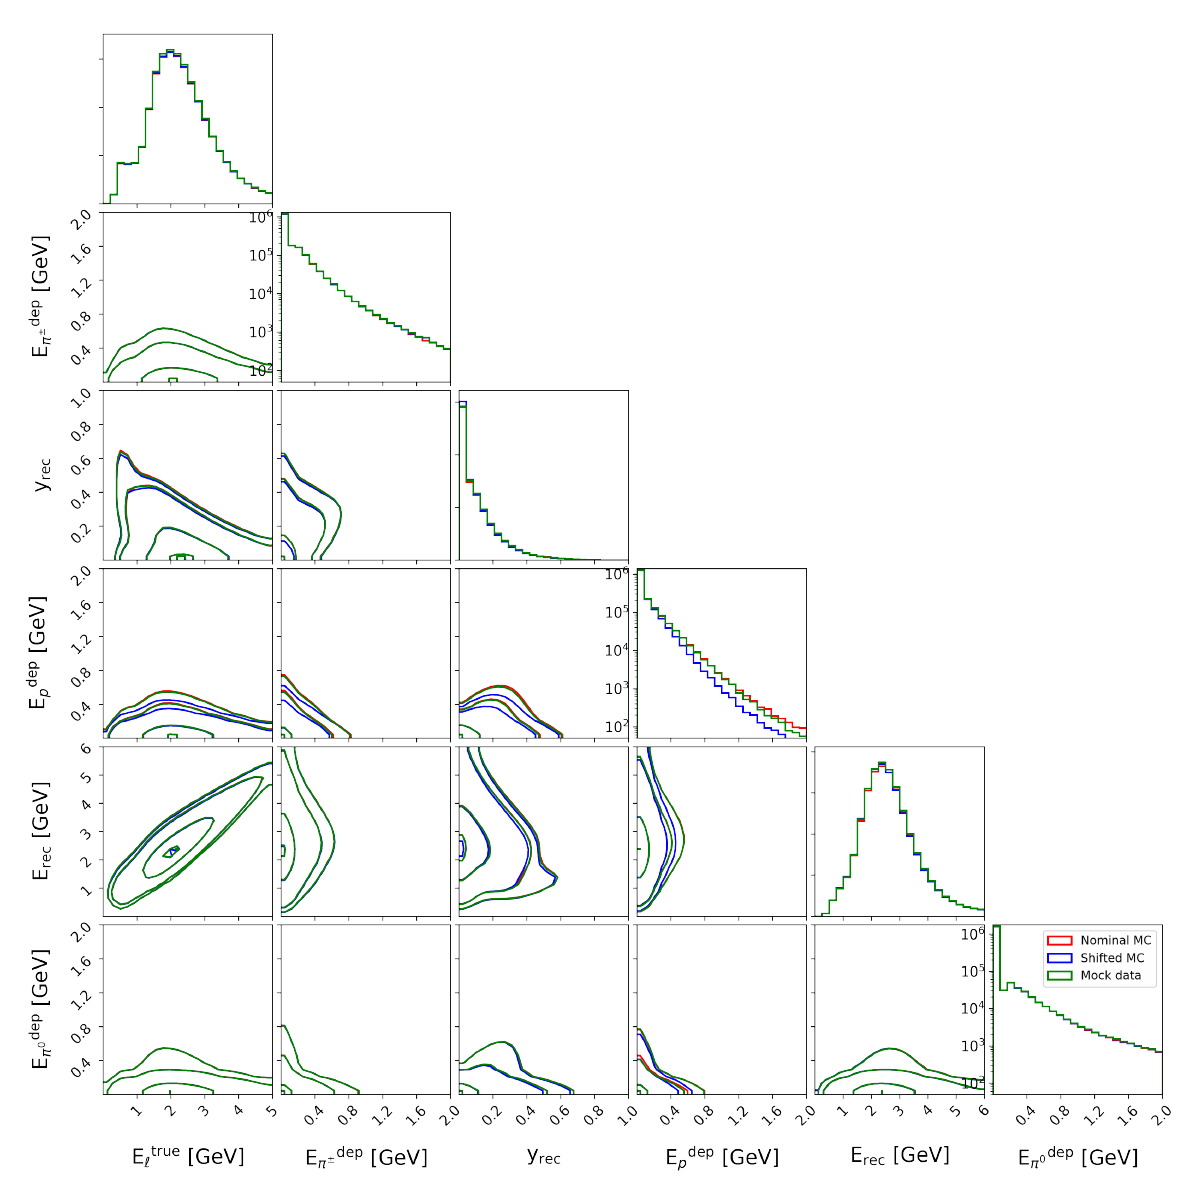
Figure 94. Multidimensional distribution of observables in RHC for the nominal sample (red), the mock data set before (blue) and after (green) reweighting. The histograms on top of the columns show one-dimensional projections of the distribution and the others show contours in pairwise two-dimensional